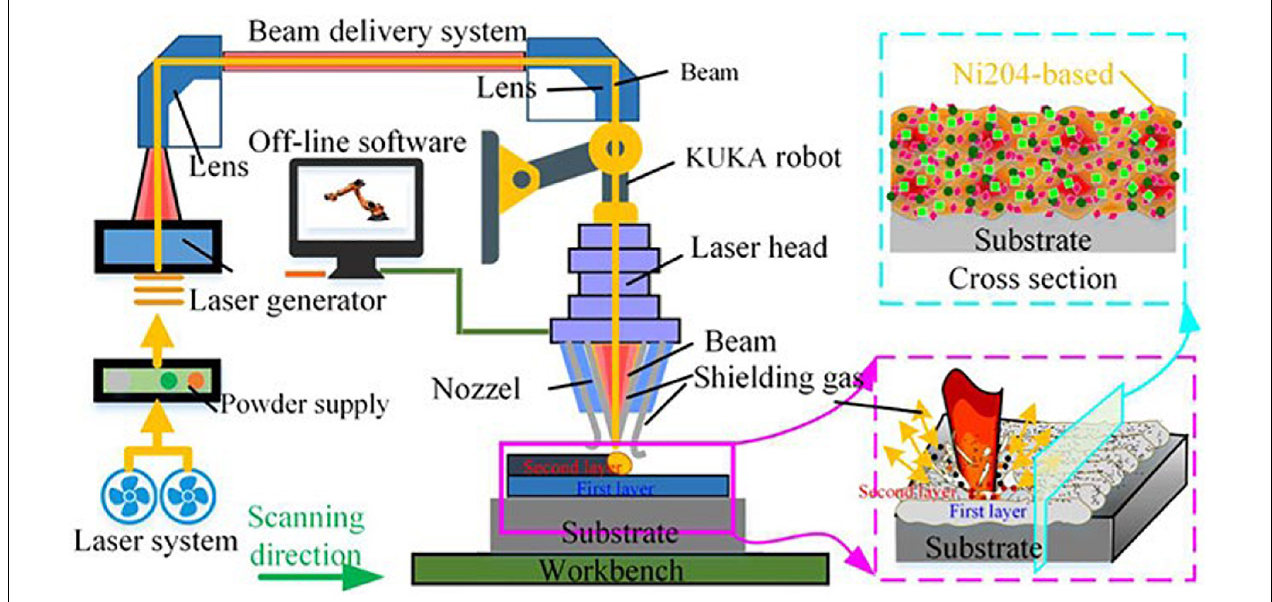
FIGURE 6 | Schematic diagram of the laser cladding (Zhao et al., 2020). Reproduced from Zhao et al. (2020) with permission.